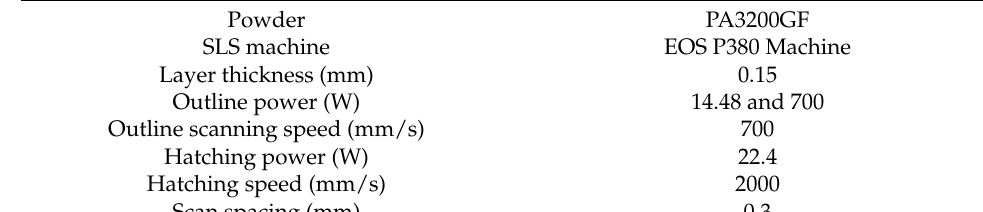
Figure 1. ( a ) Schematics of specimens’ orientation in the SLS build chamber; ( b ) fabricated SLS spec- imens, PA3200GF. Table 1. SLS of PA 3200 GF test specimens.